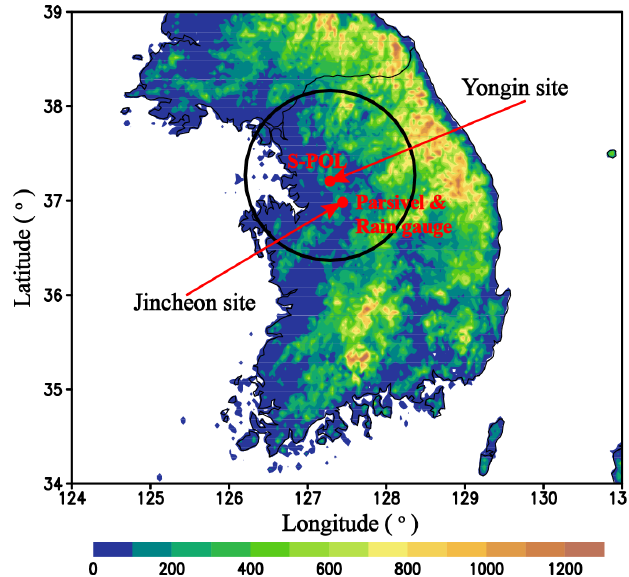
Figure 1. Geographical locations of S-band polarimetric (S-POL) radar and Parsivel disdrometer, which are located at the Yongin and Jincheon sites, respectively, in South Korea. The elevation is in